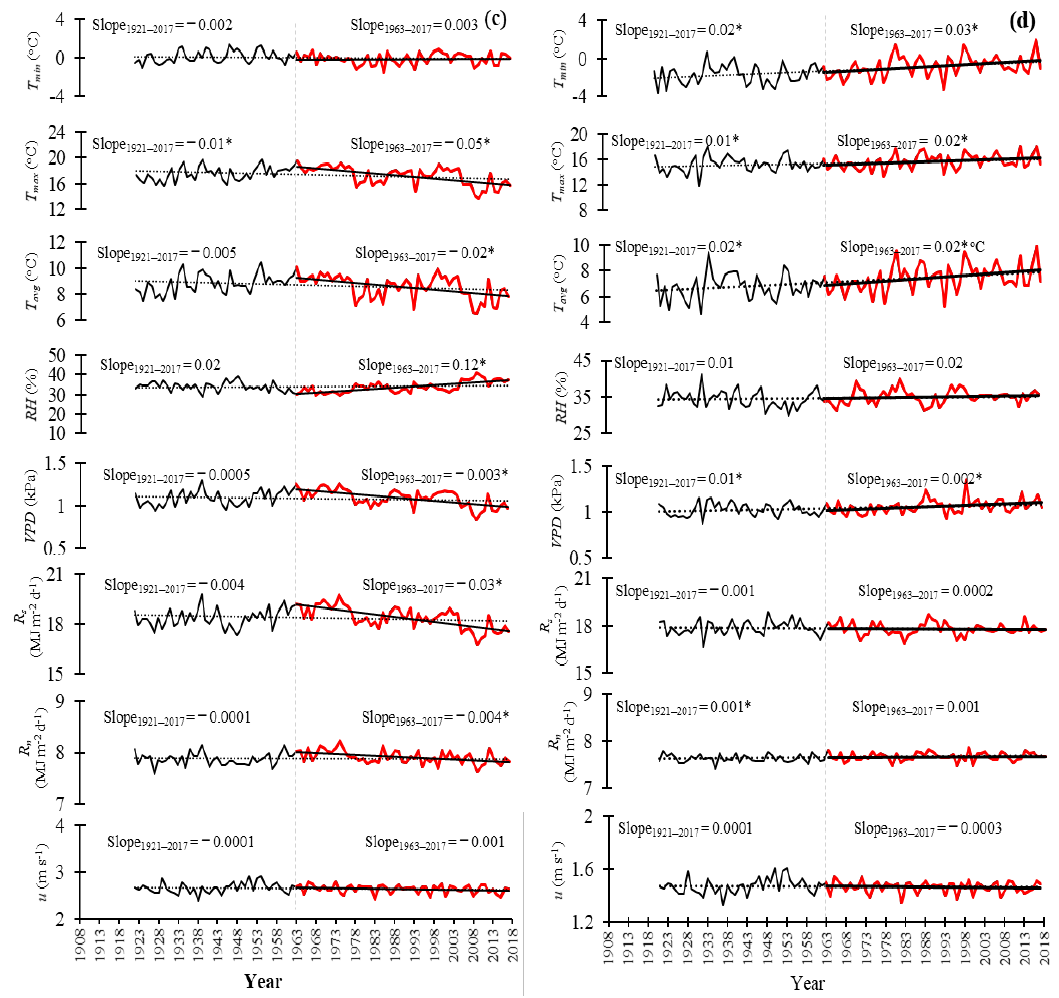
Figure 3. Temporal variation in minimum, maximum, and average temperature ( T max , T min , and T avg ; °C), relatively humidity ( RH ; %), vapor pressure deficit ( VPD ; kPa), incoming solar radiation ( R s ; MJ m −2 d −1 ), net radiation ( R n ; MJ m −2 d −1 ), and wind speed ( u ; m s −1 ) at 2 m height on an annual time–step for the period-of-record and the common period of 1963–2017 (red line) at ( a ) Pinedale, ( b ) Powell, ( c ) Torrington, and ( d ) Worland, Wyoming, with slope (yr −1 ). The asterisks (*) sign represents the significant trends at a 5% significance level. The dotted and solid black lines indicate the linear trend line for total data and the common period (1963–2017).